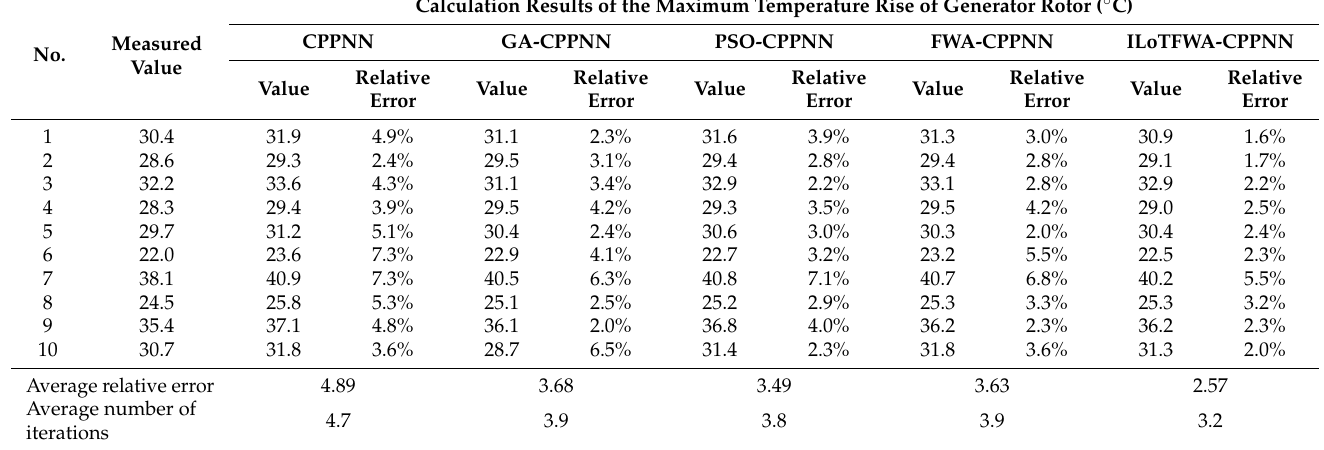
dicting the maximum temperature rise of the rotor, both in terms of the accuracy and learn ‐